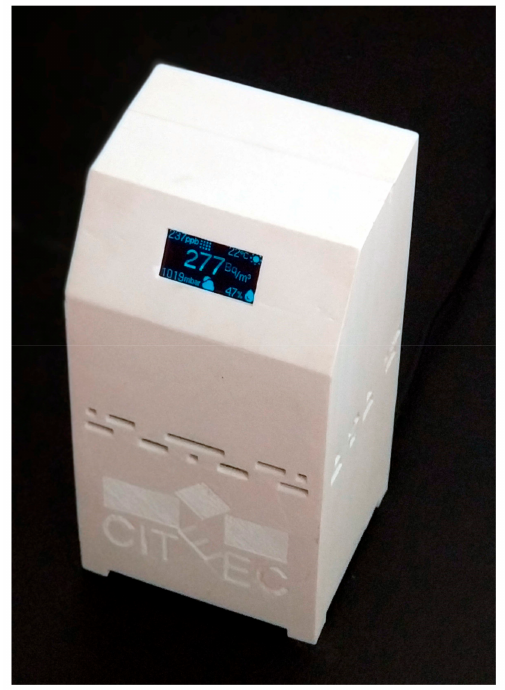
Figure 3. The air quality monitoring